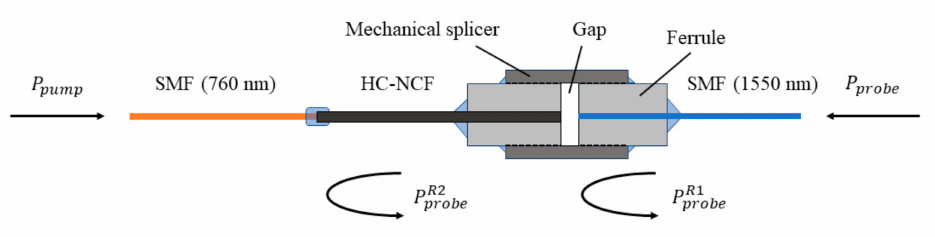
Figure 1. Schematic of the SMF / HC-NCF / SMF sensing unit. P R 1 beams at the SMF / HC-NCF